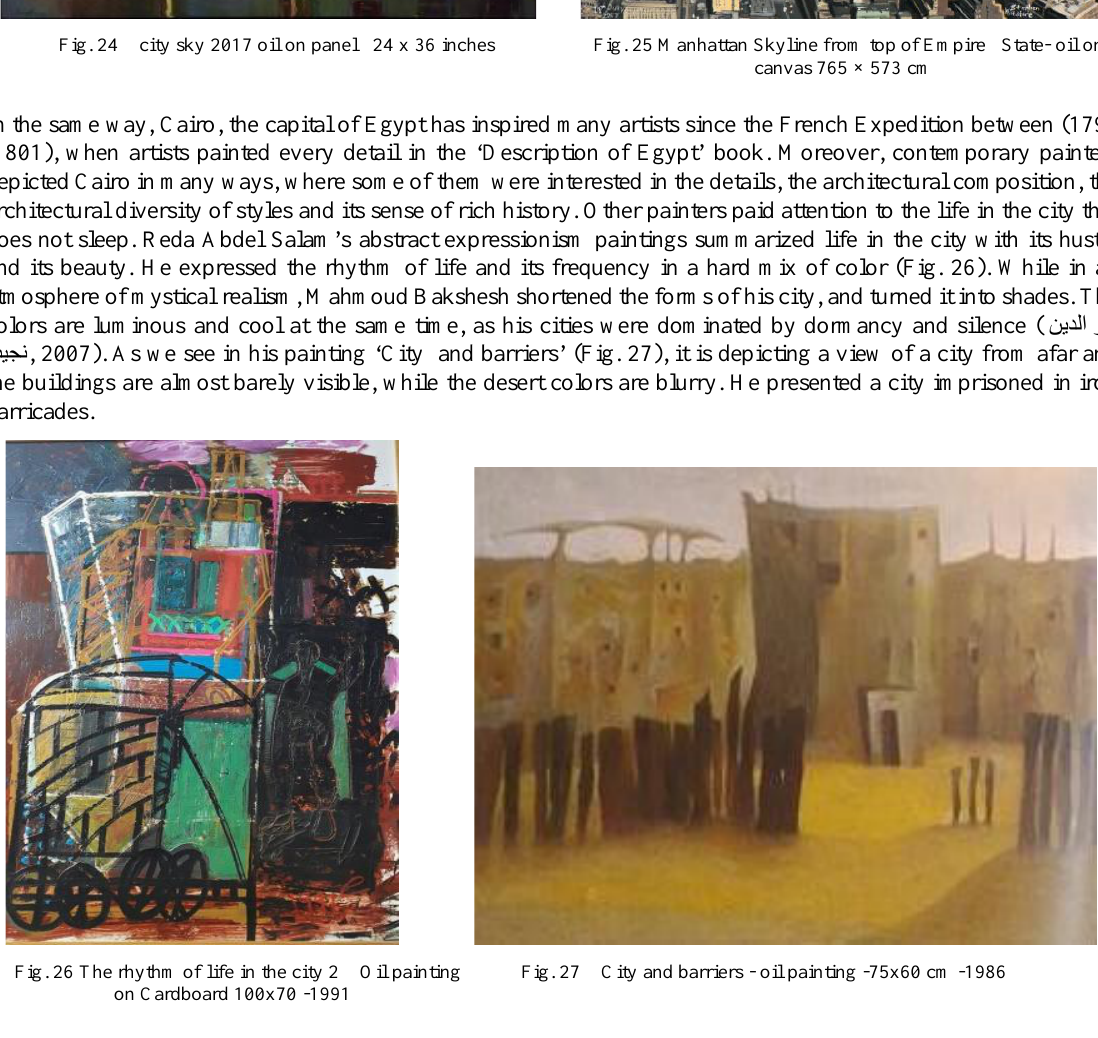
Fig. 27 City and barriers - oil painting -75x60 cm